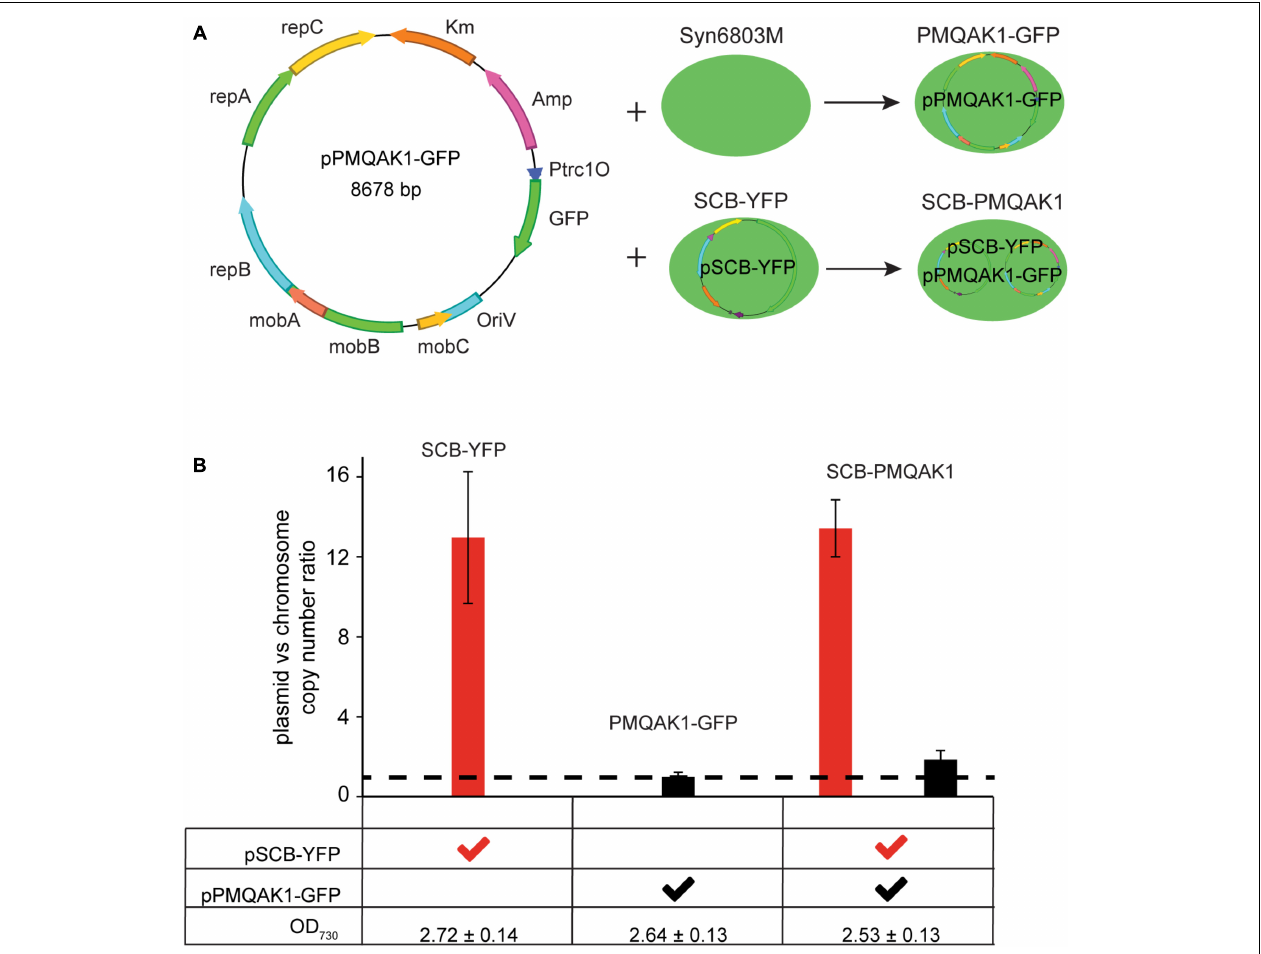
FIGURE 5 | pSCB-YFP compatibility with pPMQAK1-GFP and its copy number assay. (A) pPMQAK1-GFP, a construct based on the RSF1010 replicon, was gifted from Huang et al. (2010). It was conjugated into Syn6803M and SCB-YFP, which generated PMQAK1-GFP and SCB-PMQAK1 exconjugants, respectively. (B) pSCB-YFP and pPMQAK1-GFP plasmid copy number were assayed from three different exconjugants, SCB-YFP, PMQAK1-GFP, and SCB-PMQAK1. All the cells were taken from stationary phase when the OD 730 was ∼ 2.5 to 2.7. The plasmid to chromosome copy number ratio was calculated as the number on Y -axis. DB423 and DB424 amplicon from pSCB-YFP, and DB419 and DB420 amplicon from pPMQAK1-GFP were used as targets and single copy petB gene fragment from chromosome was used as a reference. pPMQAK1-GFP plasmid has a similar copy number to the chromosome (ratio ∼ 1; dashed line), while the pSCB-YFP plasmid copy number ratio to the chromosome is ∼ 10 to 13. Error bars represent standard deviations calculated from two biological and three technical